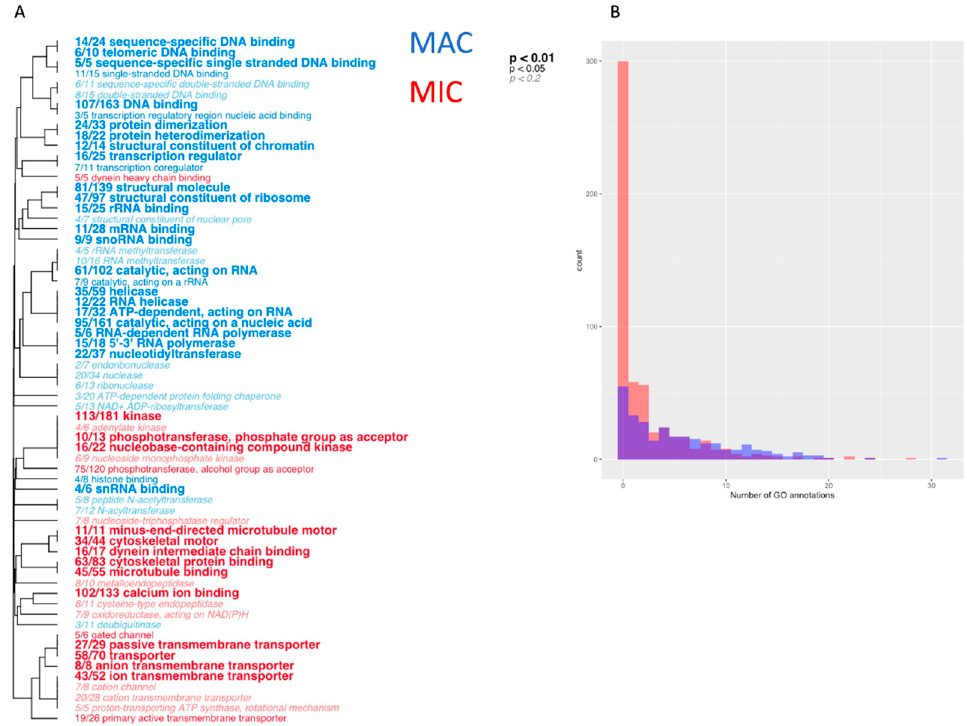
Figure 2. ( A ) GO term enrichment analysis of the nuclear samples. Terms significantly enriched in either the MAC or MIC are colored blue or red, respectively, using the Mann-Whitney U test and generated using the GO-MWU package [23]. ( B ) Histogram of the number of annotated GO terms for significantly enriched MAC and MIC proteins. A large proportion of MIC proteins lack any predicted terms.